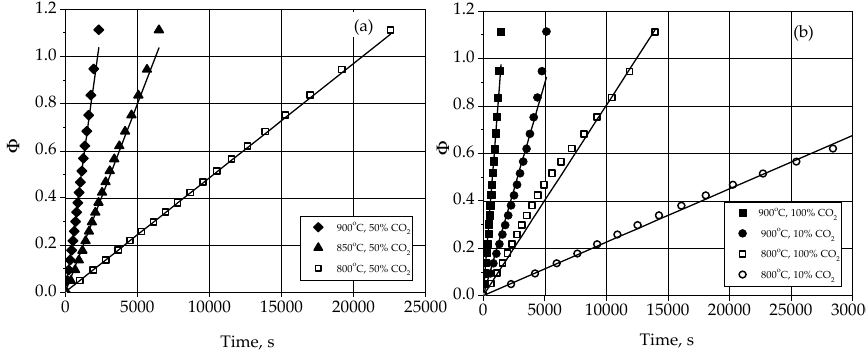
Figure 5. ( a ) Plots of the linearized experimental data with the random pore model (RPM) equation for RPC char gasification under conditions 50% CO 2 ; ( b ) 10%, 100% CO 2 .